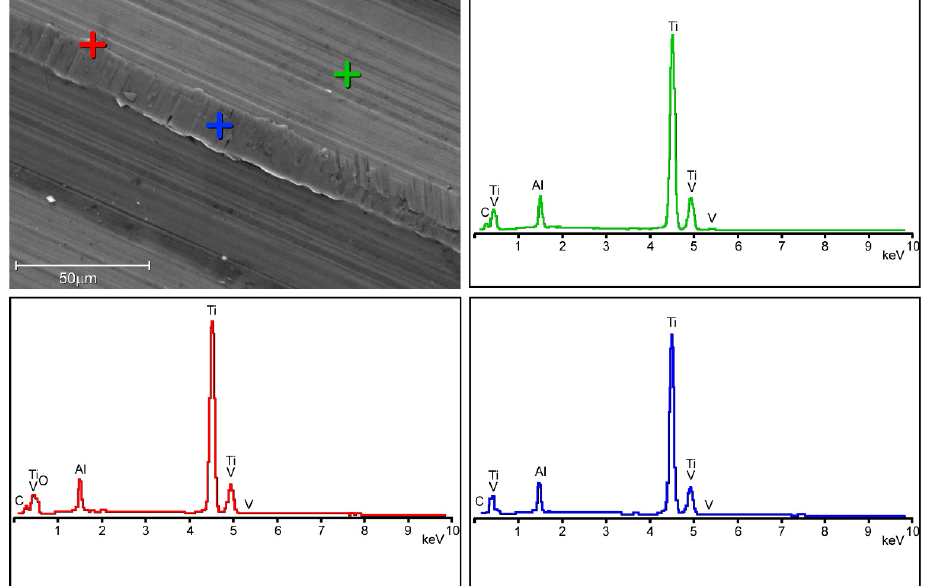
Figure 5. Same SEM image as the previous figure. EDX spectra acquired between the ridges (green spectrum), in the middle of the ridge (blue spectrum), and at the edge of the ridge (red spectrum).